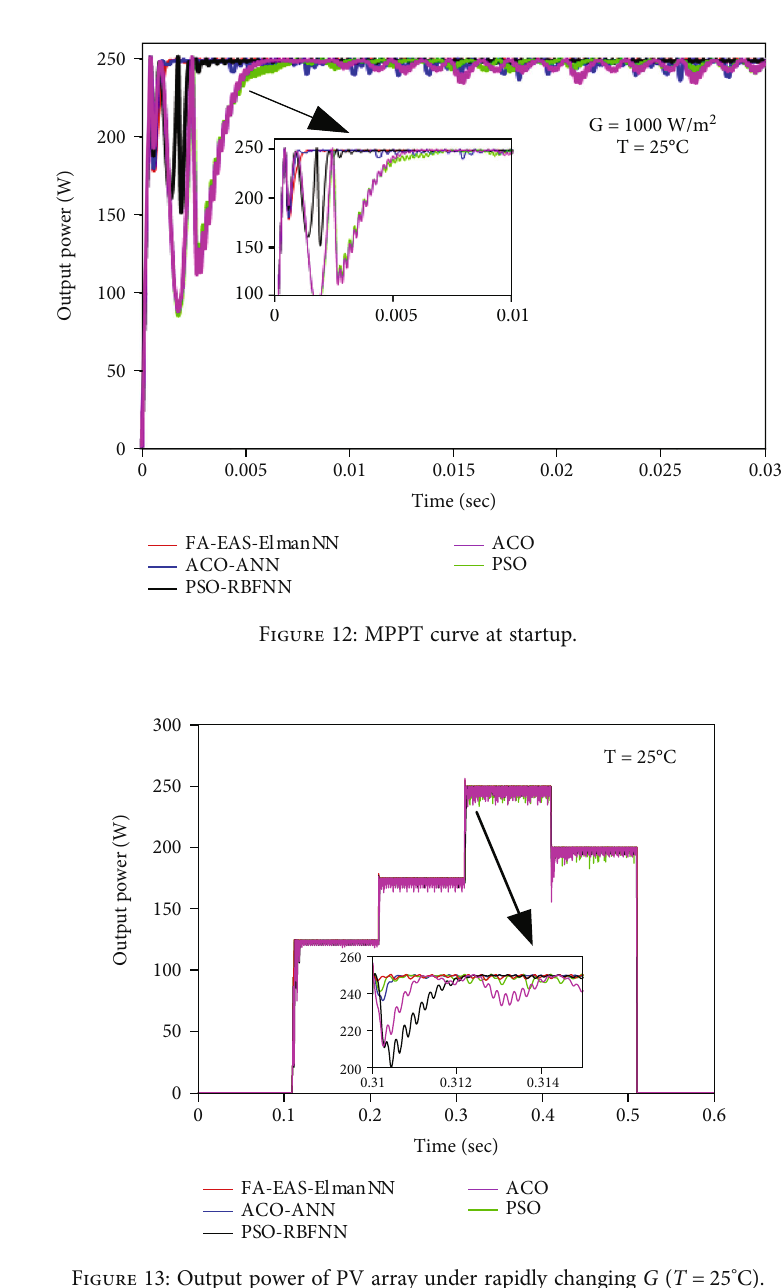
Figure 13: Output power of PV array under rapidly changing G ( T = 25 °